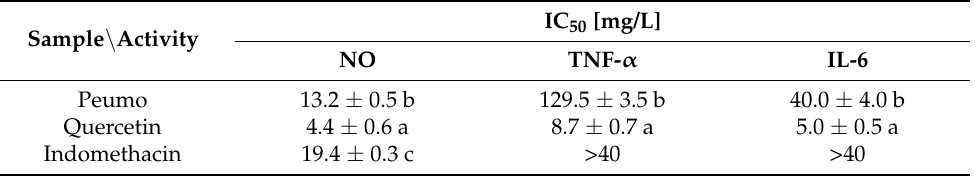
Table 5. The concentration of peumo halves the markers of inflammatory response. Data represent the average of three repetitions, with a corresponding standard error of the mean.